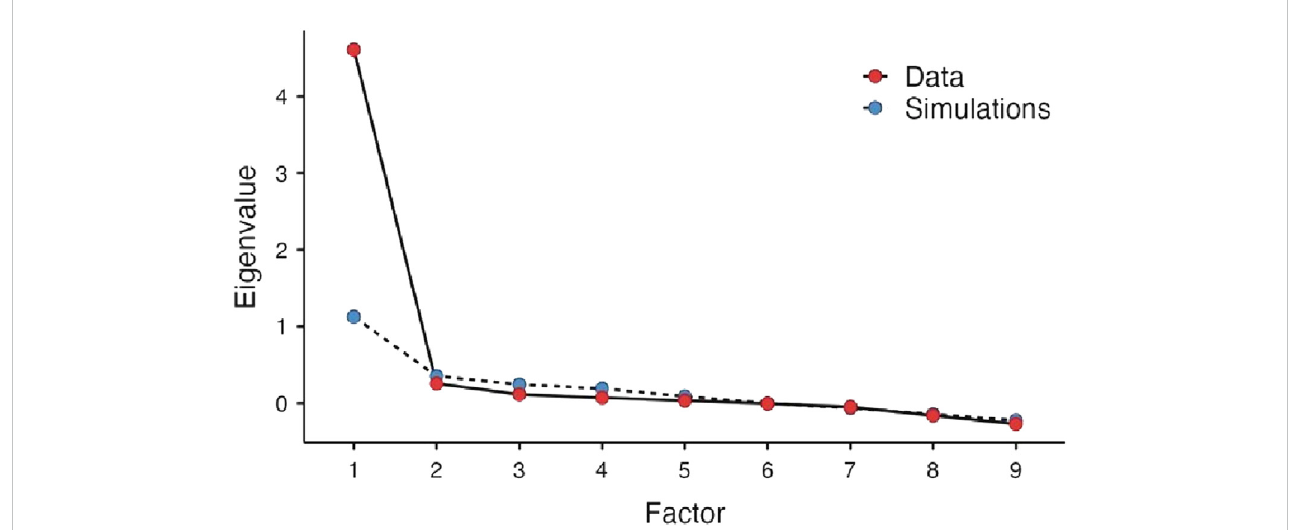
FIGURE 1 Scree plot of eigenvalues per factor.